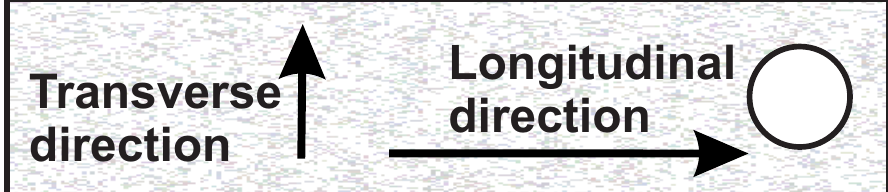
Figure 12. Roughness measurement directions in a strip.